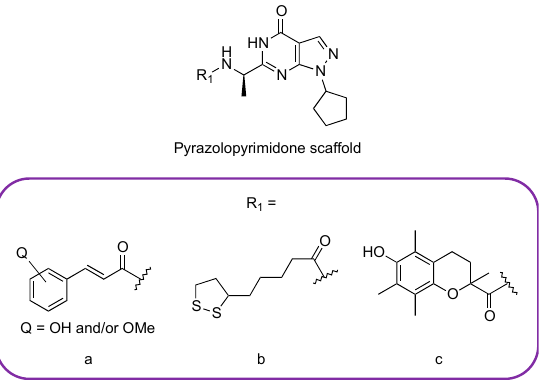
Figure 8. Chemical structures of the modified pyrazolopyrimidinone scaffold and of the moieties studied by Zhang et al., which are functional groups inspired by the structures of cinnamic acid ( a ), lipoic acid ( b ), and trolox ( c ) [57].